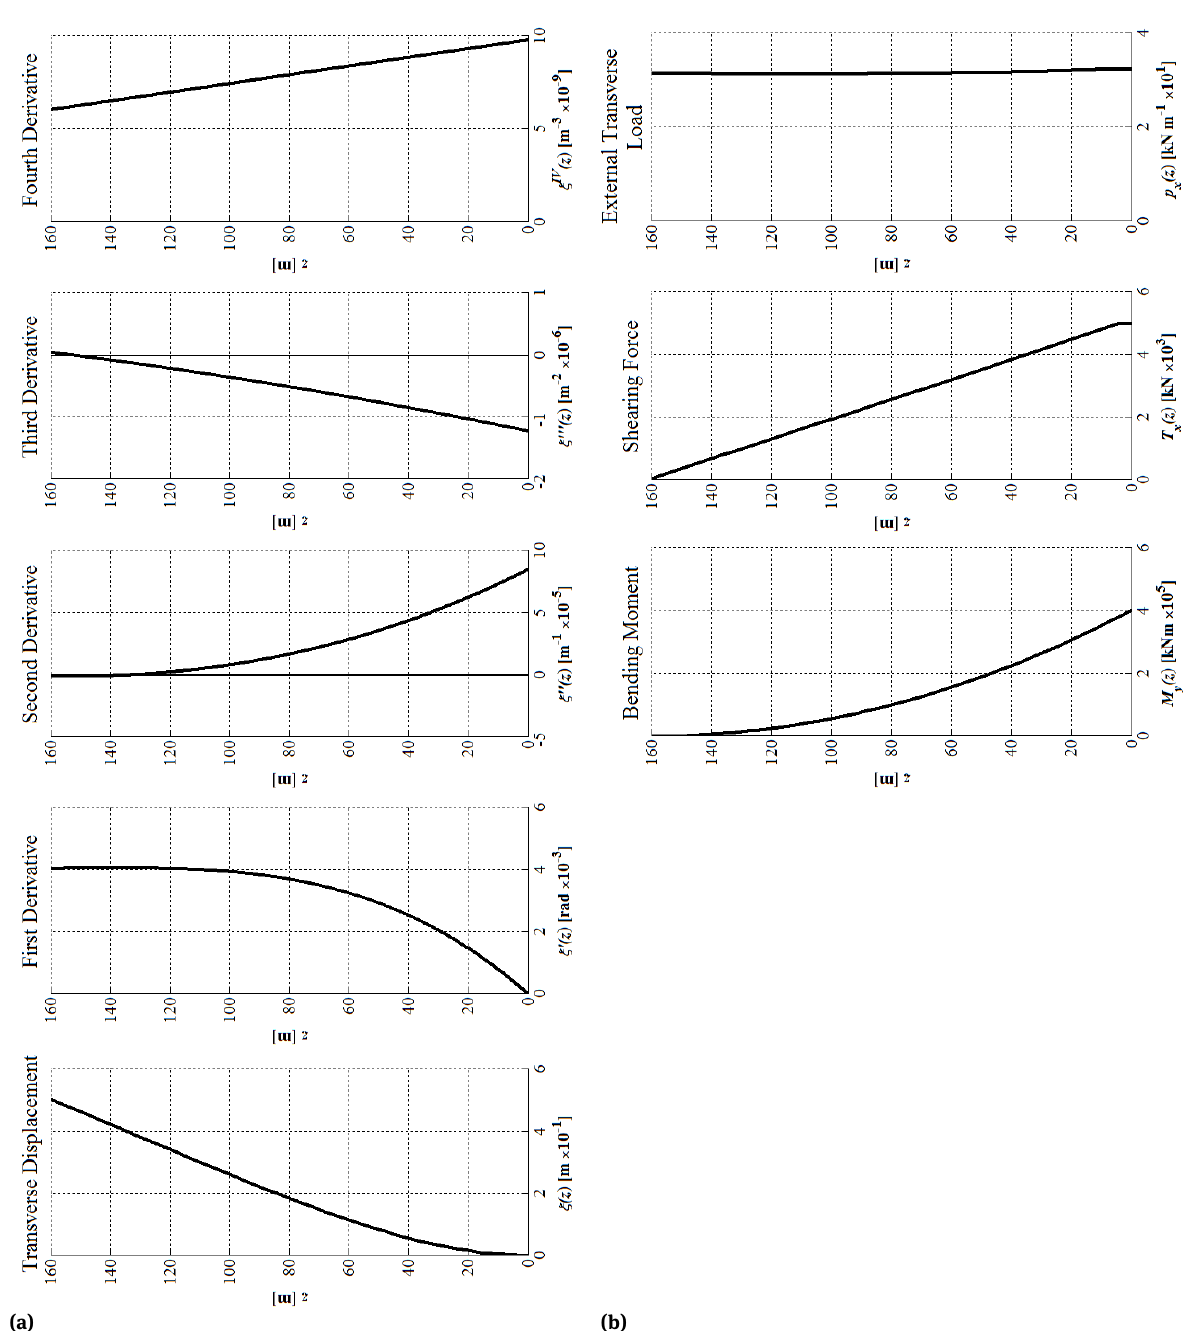
Figure 10: (a) Transverse displacement ξ ( z ) in the X direction and its successive derivatives; (b) Global internal actions M y ( z ) and T x ( z ) , and those distributed load p x ( z )